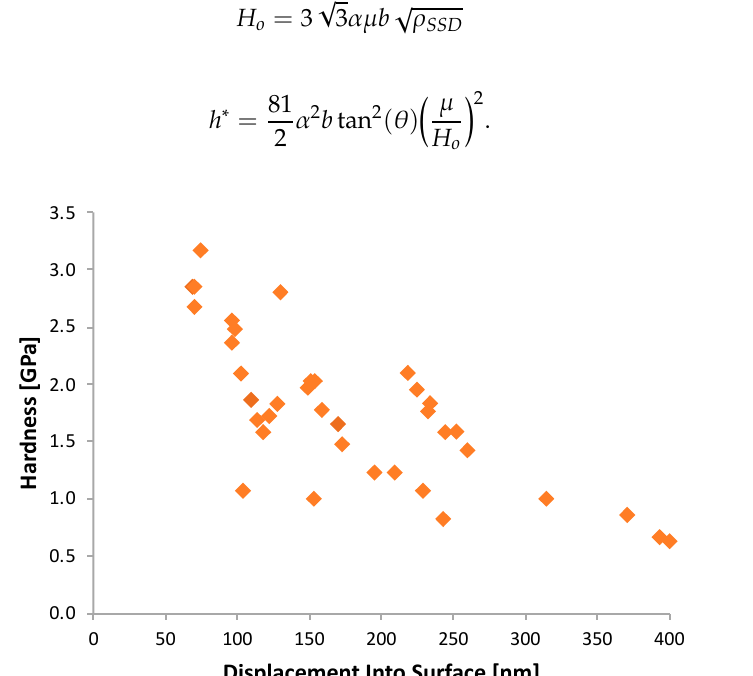
Figure 16. Tentative indentation-size-effect (ISE) data for powder; however, near 350 nm data matrix influence arises.